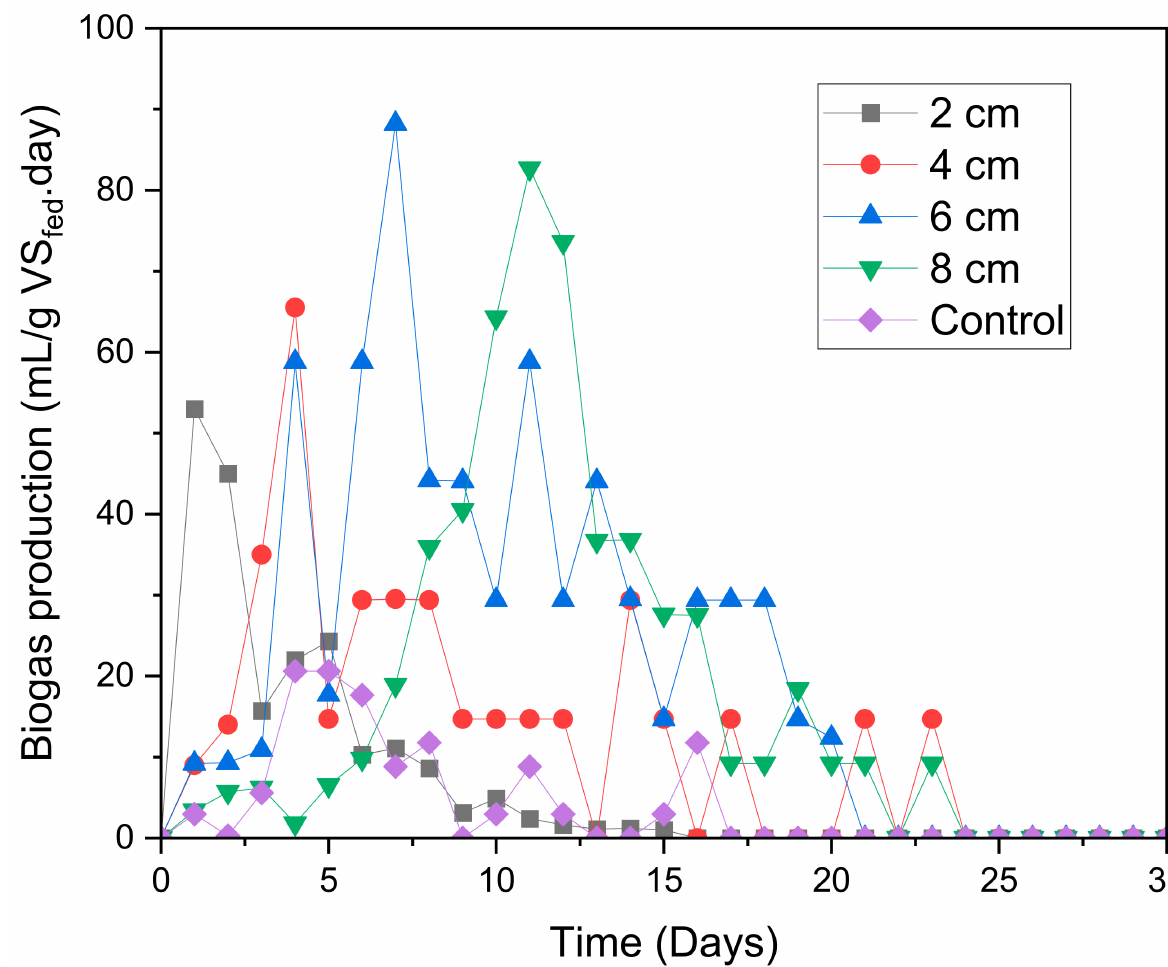
Figure 2. Daily biogas